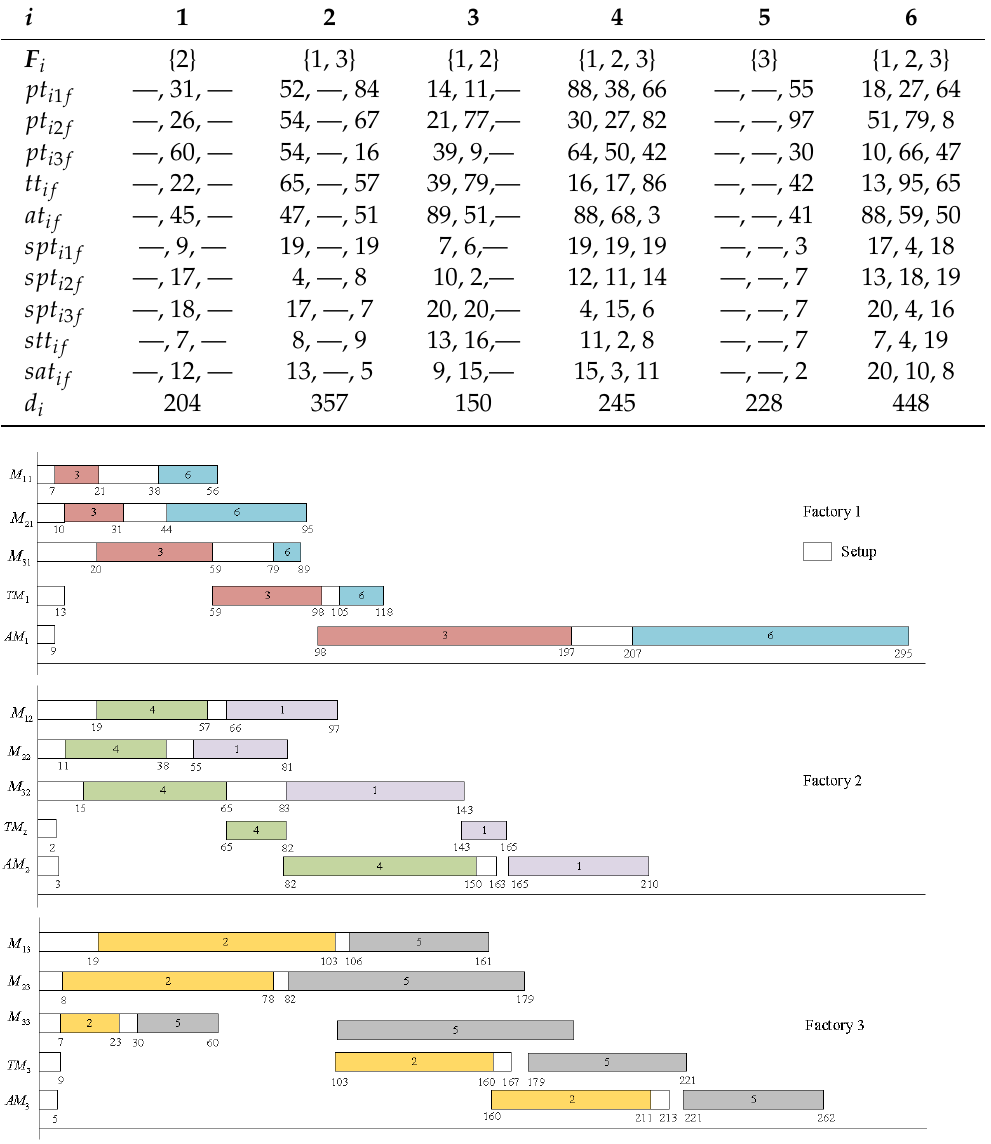
Figure 1. A schedule of the